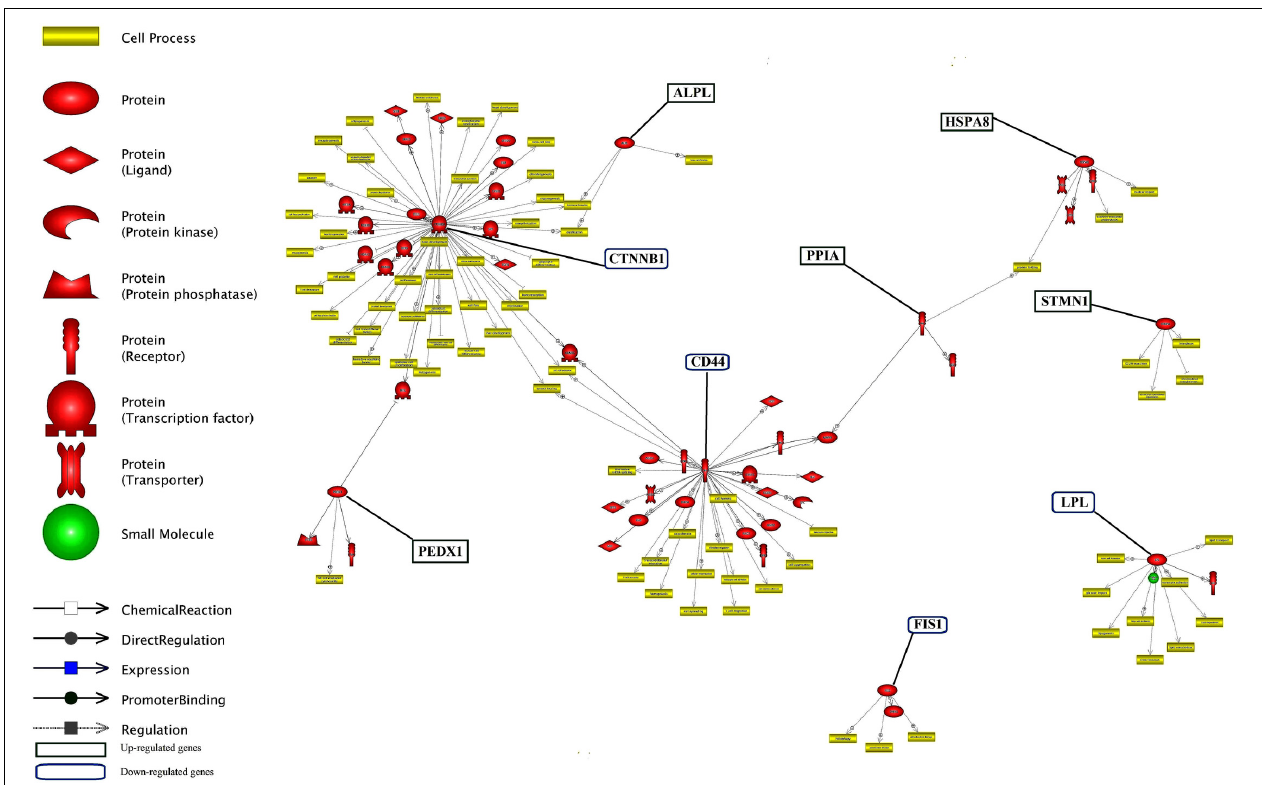
FIGURE 6 | Common target analysis between differentially expressed genes in lactation process. The green and blue boxes are up- and down-regulated genes, respectively. CTNNB1, CD44 , and LPL genes have the most common